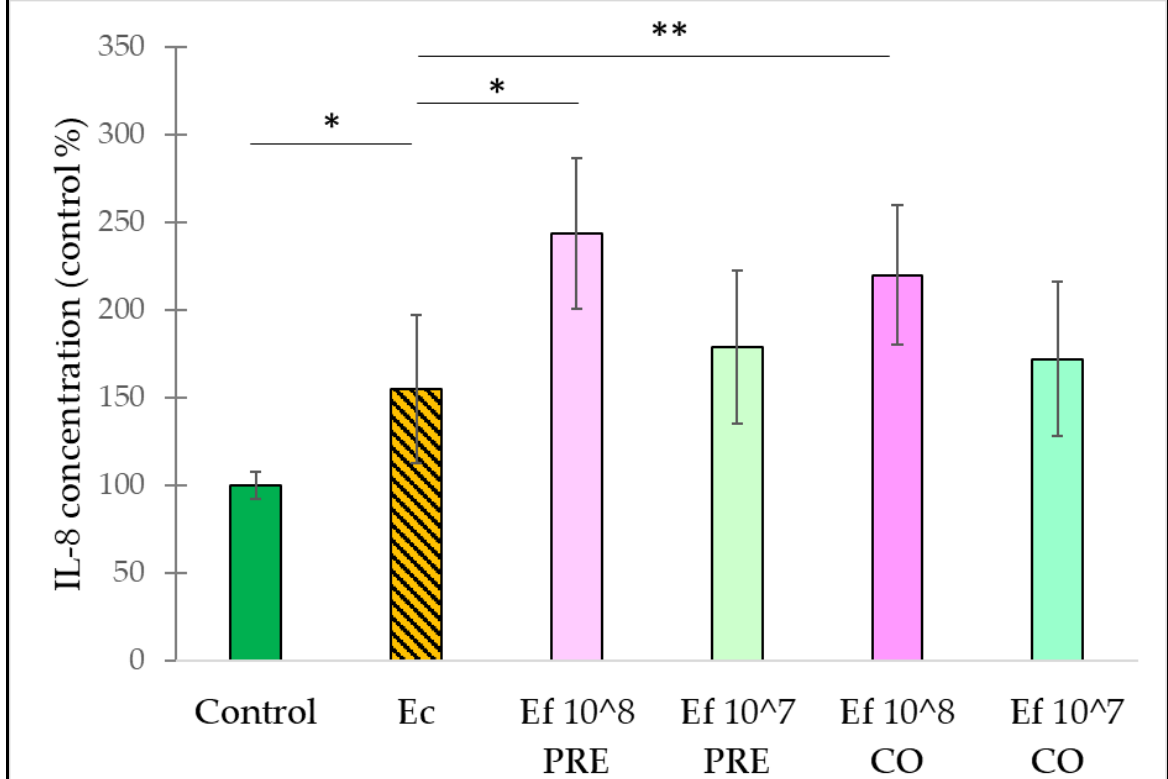
Figure 8. Induction of IL-8 secretion of IPEC-J2 cells after stimulation with E. coli and E. faecium . E. faecium was added 1 h before (pre-treatment) or at the same time (co-treatment) of the addition of E. coli . E. faecium was added in 10 8 CFU/mL or in 10 7 CFU/mL concentration. Control : plain cell culture medium treatment; Ec : E. coli 10 6 CFU/mL; Ef 10^8 PRE : pre-treatment with E. faecium 10 8 CFU/mL + E. coli 10 6 CFU/mL; Ef 10^7 PRE : pre-treatment with E. faecium 10 7 CFU/mL + E. coli 10 6 CFU/mL; Ef 10^8 CO : co-treatment with E. faecium 10 8 CFU/mL + E. coli 10 6 CFU/mL; Ef 10^7 CO : co-treatment with E. faecium 10 7 CFU/mL + E. coli 10 6 CFU/mL. Data are shown as means with stand- ard deviations, n = 6/group. * p ≤ 0.05; ** p ≤ 0.01.